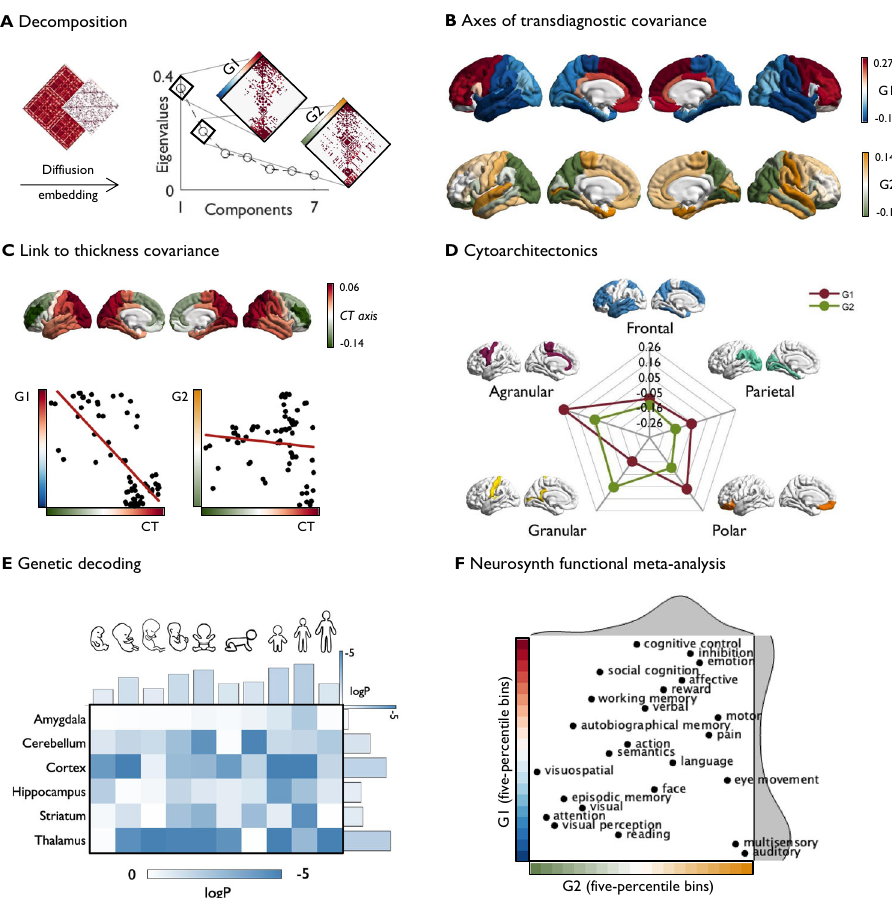
Fig. 2 | Macroscale organization of transdiagnostic covariance in cortical thickness alterations. A A cross-disorder structural covariance matrix was thre- sholded at 80% and decomposed using diffusion map embedding. Covariance along the principal (G1) and second (G2) gradients is depicted on the right. B Transdiagnostic gradients G1 and G2. C Correlation between a normative axis of cortical thickness (CT) covariance 36 and transdiagnostic gradients. D Cross- condition gradients strati fi ed according to von Economo-Koskinas cytoarchitec- tonic classes 51 . E Developmental gene enrichment analysis based on 232 genes for